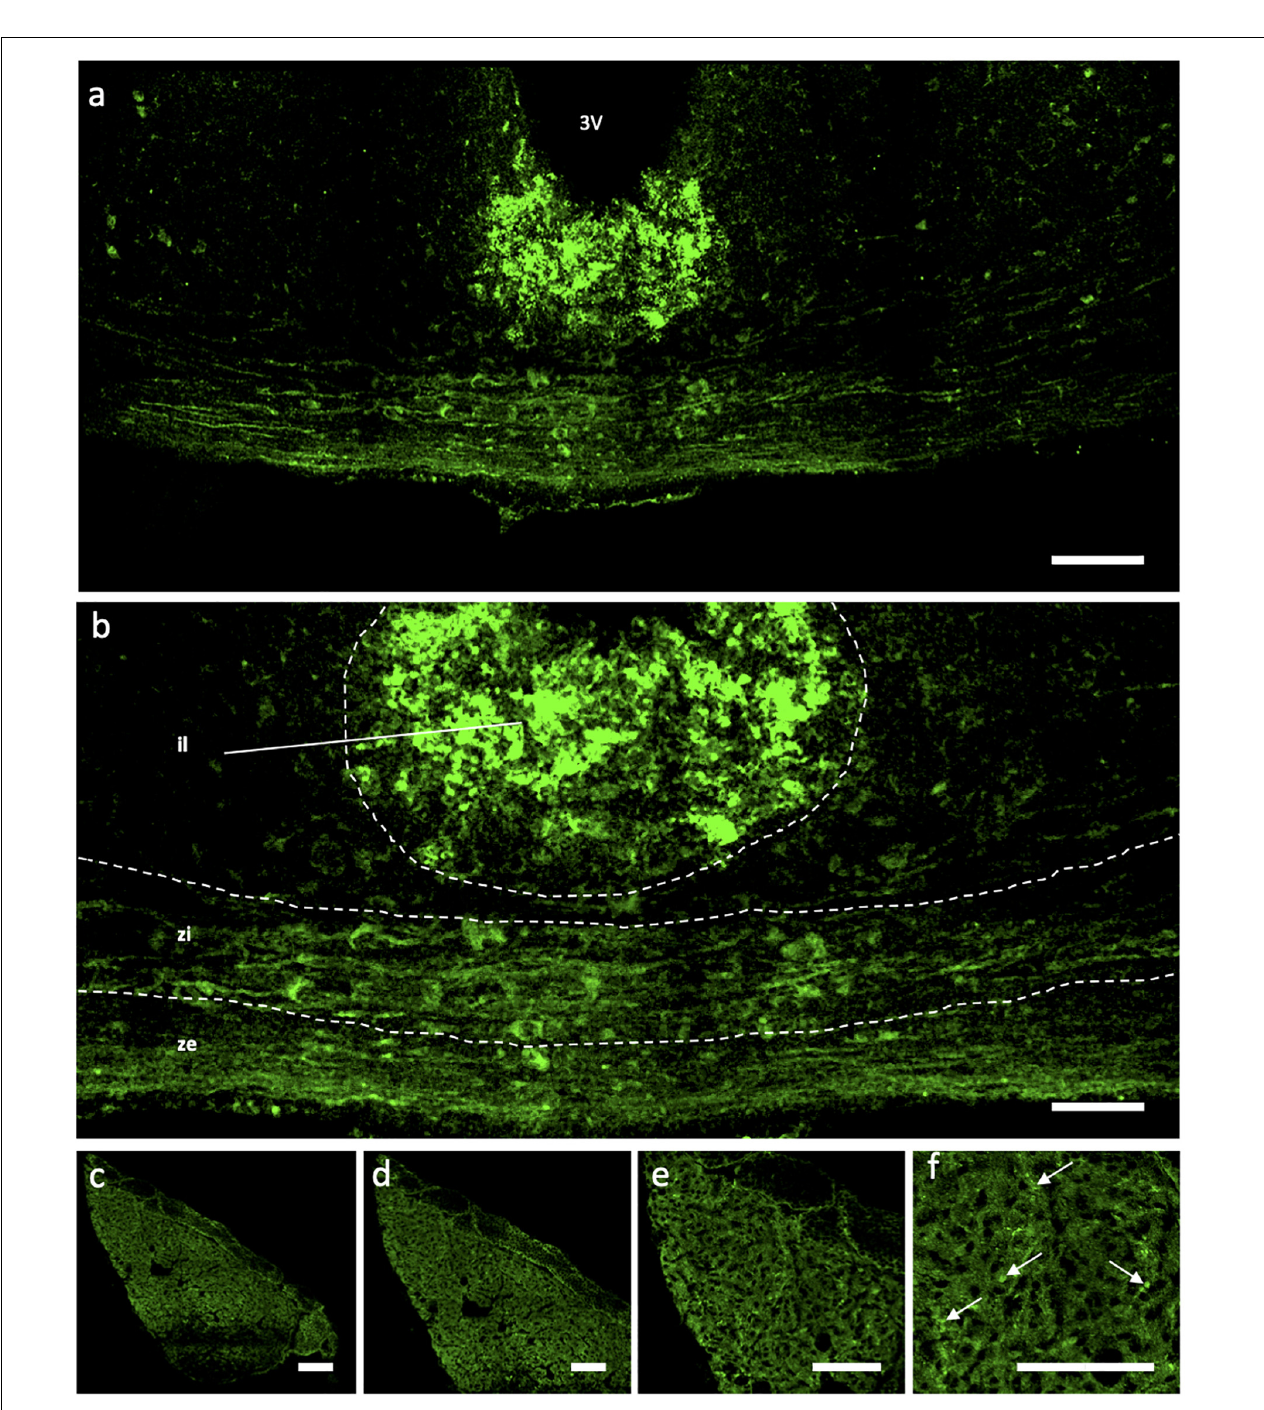
FIGURE 4 | Immunohistochemical Analysis of Urocortin expression in Median Eminence and pituitary of rat. Expression of Ucn (green) was found within all areas (il, zi, ze) of the ME (a,b) as well as punctate staining located within the upper portion of the ME at the bottom of the 3V. Within the posterior lobe of the pituitary (c–f) , robust but diffuse Ucn expression was found throughout, with areas of particular punctate fluorescence (f; arrows). 3V, Third Ventricle; ME, median eminence; il, internal lamina; zi, zona interna; ze, zona externa; Ucn, Urocortin. Scale Bar = 100 µ m.